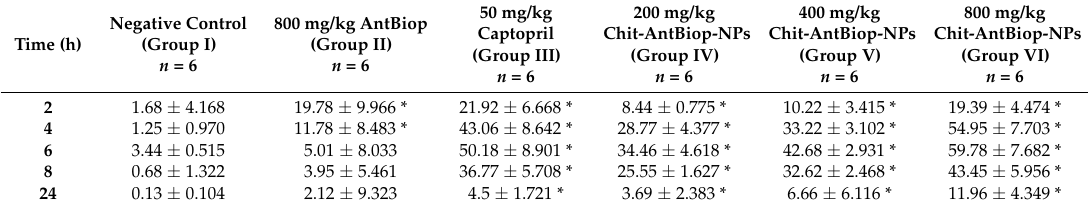
Table 2. The magnitude of systolic blood pressure reduction due to a single oral dose on spontaneously